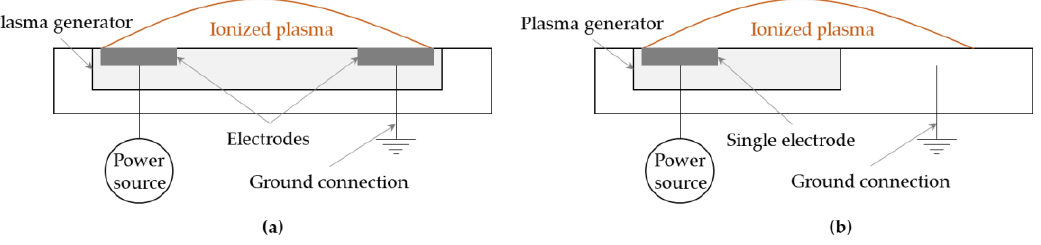
Figure 15. Plasma generator concepts for reducing the strength of a transonic shock based on [96,97].